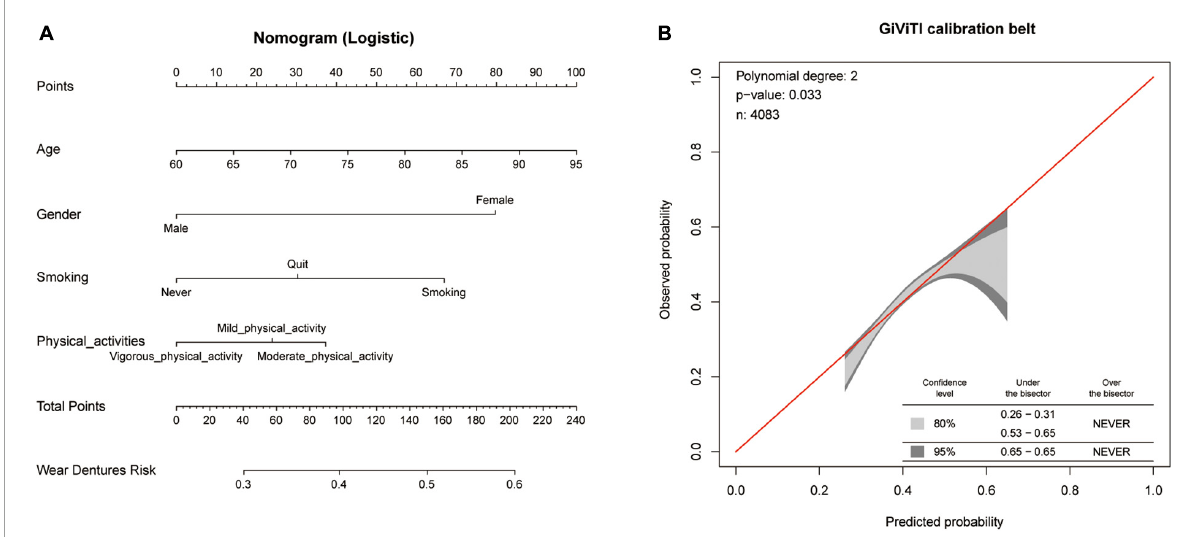
FIGURE2 Logistic regression analysis to determine the factors associated with denture use in the presence or absence of cognitive impairment. (A) Denture wearing status was predicted by the nomogram prediction model based on age, sex, smoking status, and physical activity. A nomogram consists of three main parts: (I). the scoring part, which represents each variable at different values by a single score; (II). the indicator part, which includes such variables as age, sex, smoking, and physical activity. On the line segment, each indicator is marked with a scale that indicates its range of values. Indicators contribute to the ending event based on their length of line segments in the diagram; (III). the ending segment, i.e., total points and wear dentures risk in the diagram, where total points indicate the total score of all indicators after taking the values of the corresponding individual scores together. Probability indicates the likelihood of achieving a goal when an event occurs; (B) This nomogram’s calibration